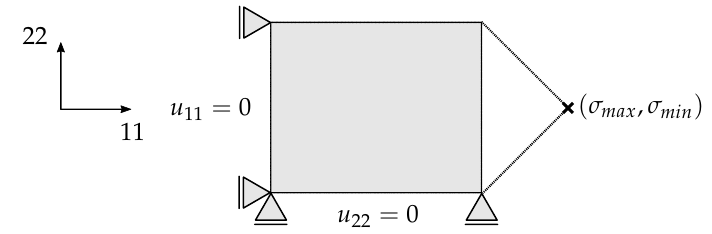
Figure 13. Mechanical model with boundary conditions for coupling to the FDM.